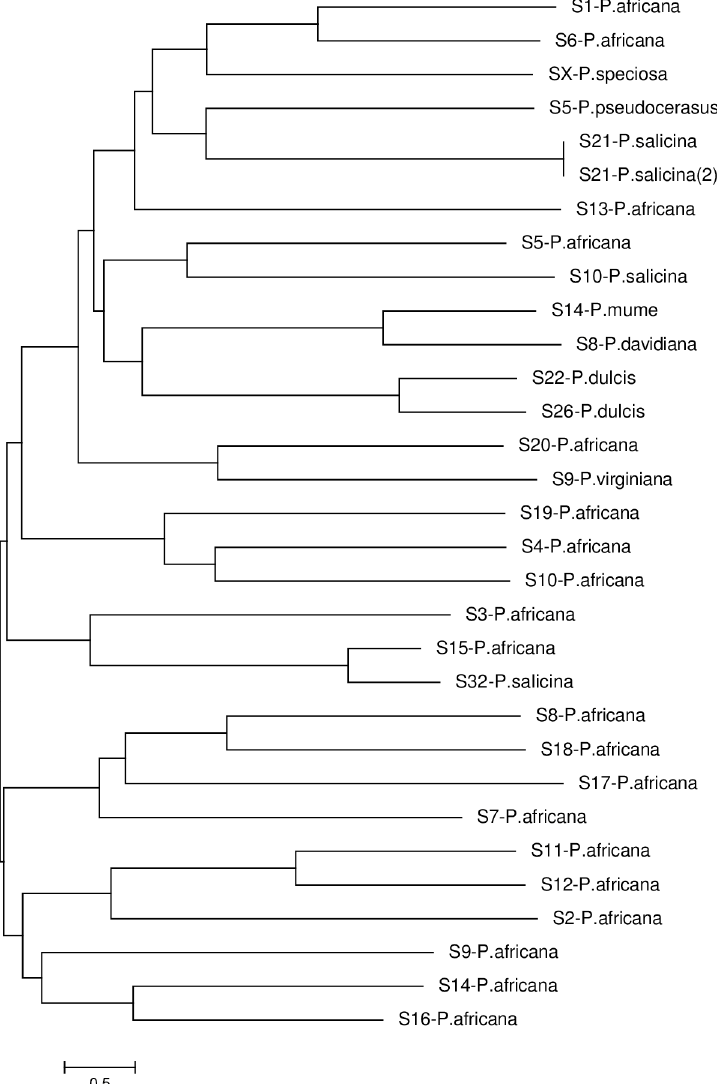
Fig 5. Phylogenetic tree (minimum evolution) of P . africana and other Prunus second intron S -RNase sequences depicting relationships with other congeneric species. Allele sequences are highly diverged and partially are similar to S -allele sequences obtained in other Prunus species, a pattern commonly observed as alleles are older than the species